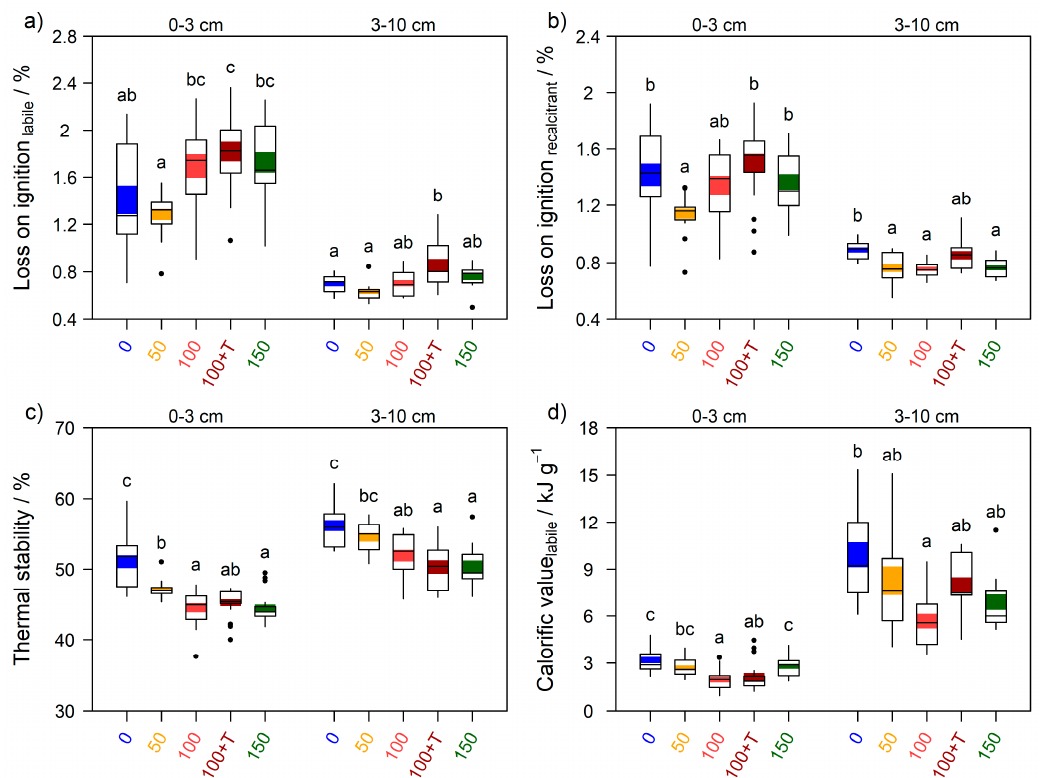
Figure 5. Thermogravimetric analysis of soil organic matter in soil depths of 0–3 and 3–10 cm: ( a ) mass loss on ignition of the labile temperature range; ( b ) mass loss on ignition of the recalcitrant temperature range; ( c ) thermal stability index; ( d ) calorific value of the labile fraction. Boxplots show the median and ranges from the 25th to the 75th percentile; the whisker length was set to 1.5 times the interquartile range. OMW application rates are 0 (control), 50, 100, and 150 m 3 ha − 1 y − 1 and 100 m 3 ha − 1 y − 1 followed by shallow tillage (100 + T). Colored overlays indicate the standard deviation of the mean. Mean values within one soil depth followed by the same letter were not statistically different ( p ≤ 0.05).